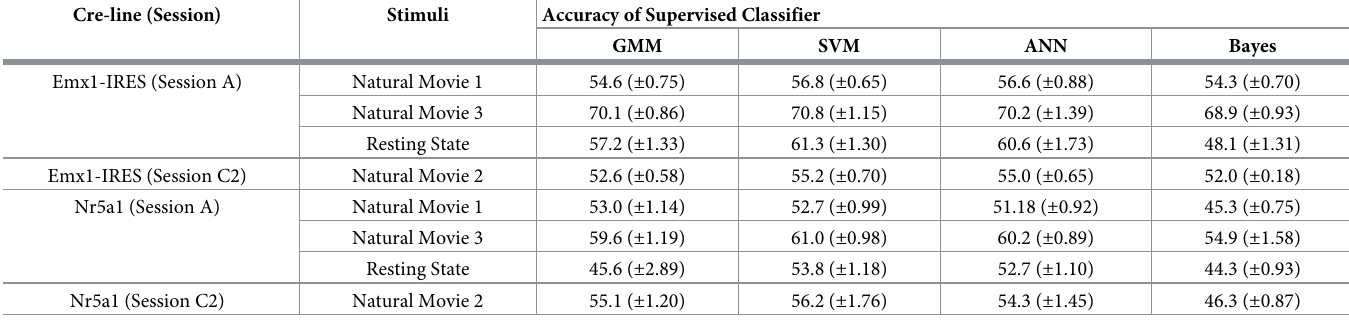
Table 4. Accuracy of supervised classification on two-photon dataset. The results are averaged across random initializations. The entries denote “ % accuracy (± standard deviation) ”.